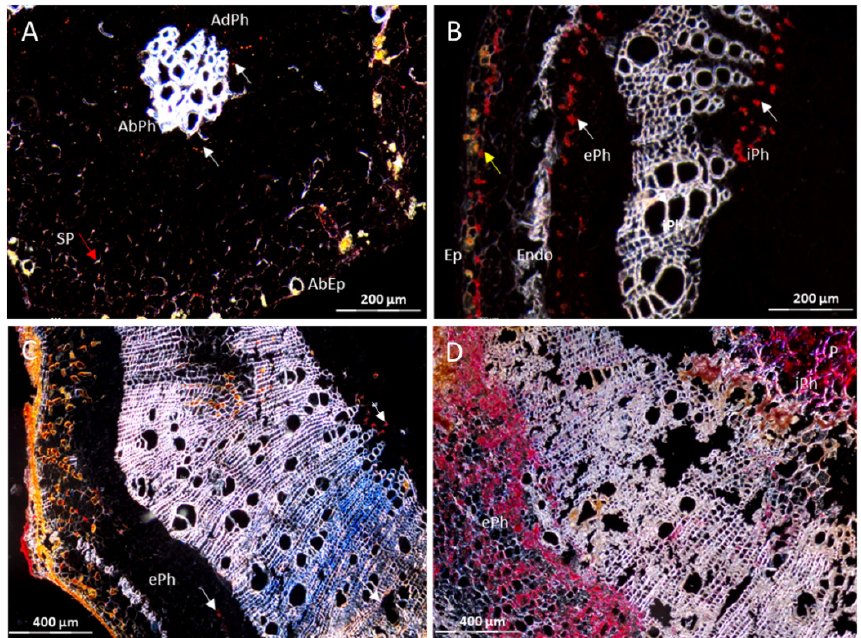
(Figure 8B,C, white arrows) and in the phellogen (Figure 8B, yellow arrows). In the susceptible TMS 96/0304, the virus was found in all cell types at a high intensity (Figure 8 D).